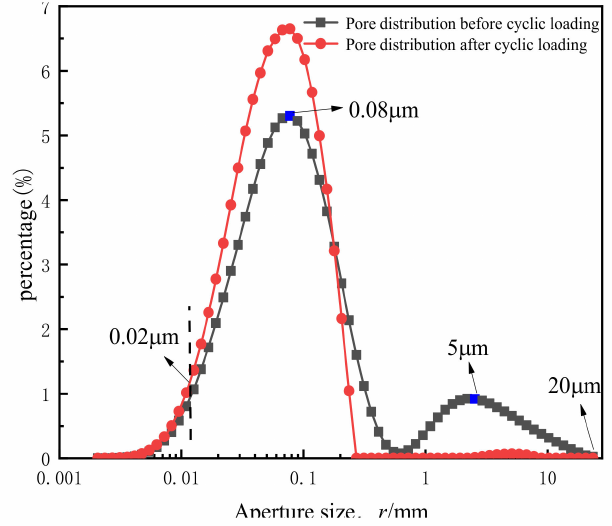
Figure 13. Comparison of pore size distribution.